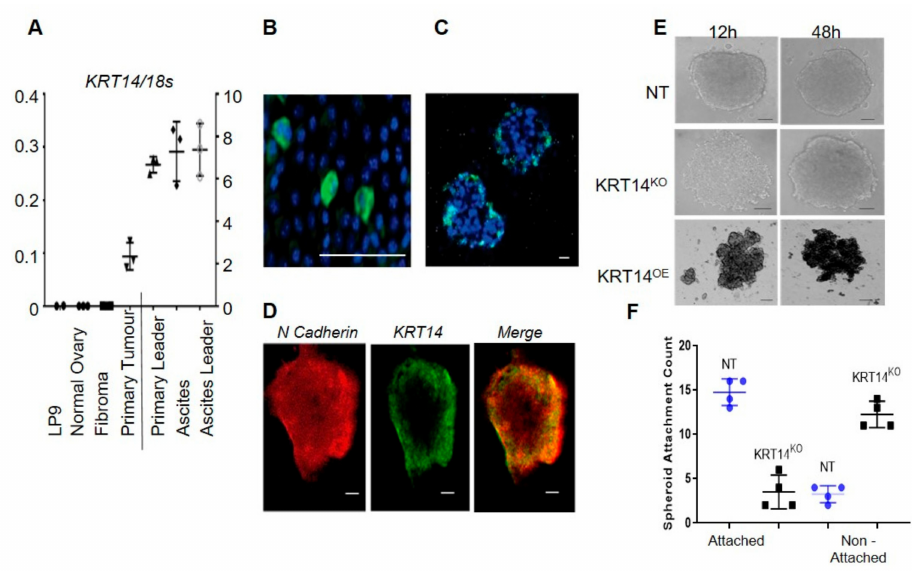
Figure 4. ( A ) Representative qRT-PCR of KRT14 expression in LP9 cells, whole normal ovary, benign fibroma, primary ovarian tumour, or ascites-derived cells; and migratory leader cell populations ( n = 3 separate patient isolations where individual data points represent individual patient samples). ( B ) KRT14 expression in cultured cells by immunofluorescence. KRT14 expression was detected as a granular cytoplasmic stain expressed by a small proportion of ovarian cancer cells in the OVCAR4 line cultured as a two-dimensional (2D) monolayer. Scale bar = 100 µ m. ( C ) KRT14 expression was detected at the periphery of OVCAR4 ovarian cancer cells cultured as three-dimensional (3D) spheroids with no signal detected in the core of the spheroid. Scale bar = 100 µ m. ( D ) Localisation of KRT14 at the periphery of ovarian cancer spheroids by comparison to the intracellular staining observed for N-cadherin. Scale bar = 100 µ m. ( E ) Vector control (NT), KRT14 KO , and KRT14 OE cells were suspended in SFM / 0.25% methylcellulose in U-bottom 96-well plates and imaged at regular intervals (0–48 h) to observe spheroid aggregation. Images are representative of multiple wells observed at the 13-hour and 48-hour time points. Scale bar = 100 µ m. ( F ) Spheroid attachment to the target mesothelium. Vector control (NT) and KRT14 KO spheroids were co-cultured with the target mesothelium, and attachment was measured 6 h post-addition. The results presented are from one representative assay where data points are the attachment counts of three individual wells per cell